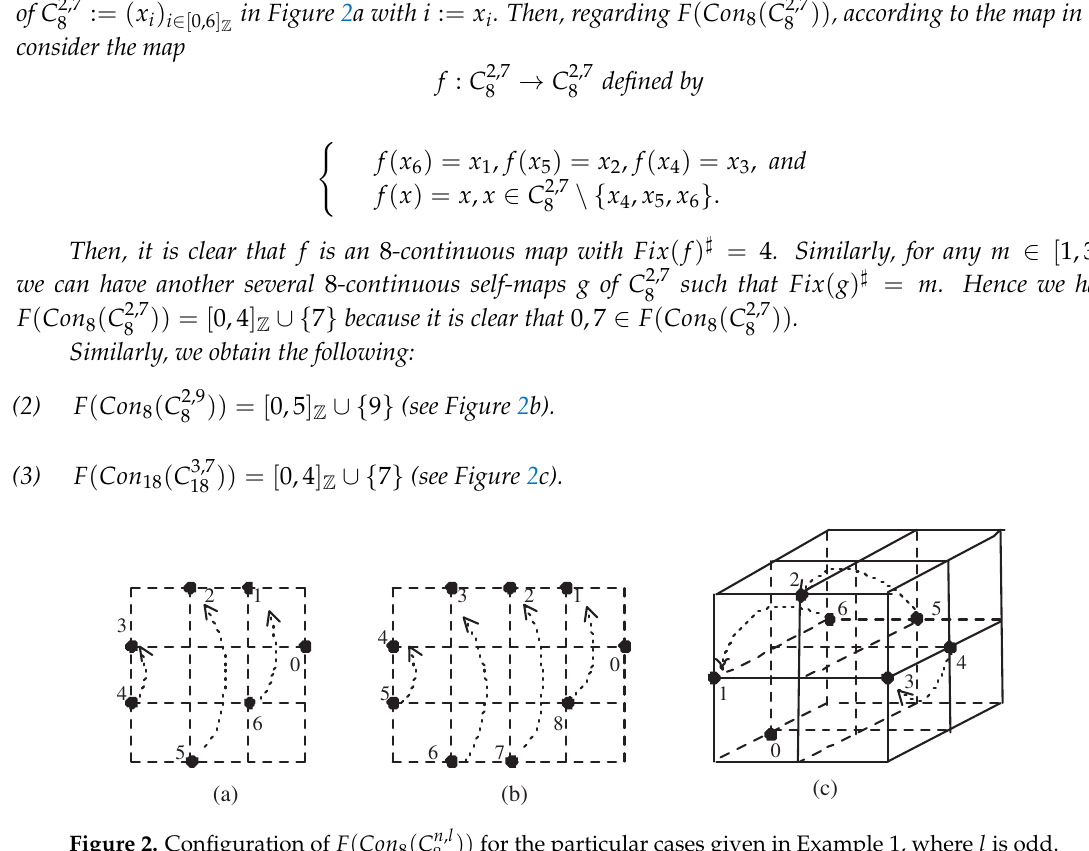
Figure 2. Configuration of F ( Con 8 ( C n , l